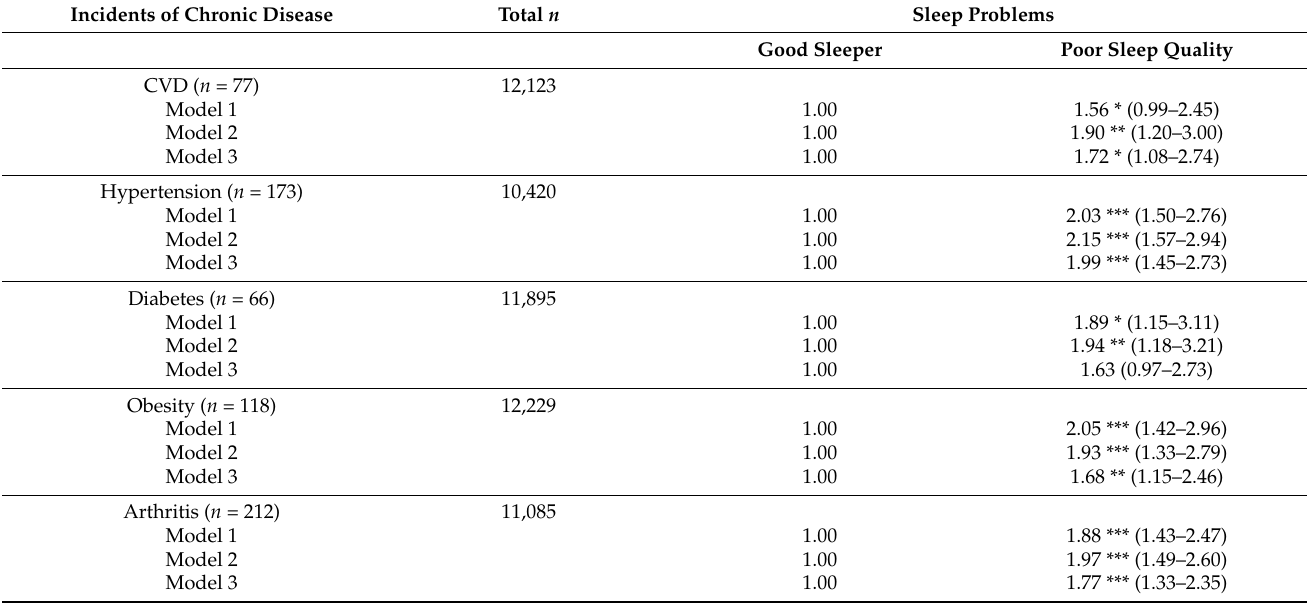
Table A3. Odds ratios (95% Confidence Intervals) for incidents of chronic disease according to the level of sleep problems over 15 months during the COVID-19